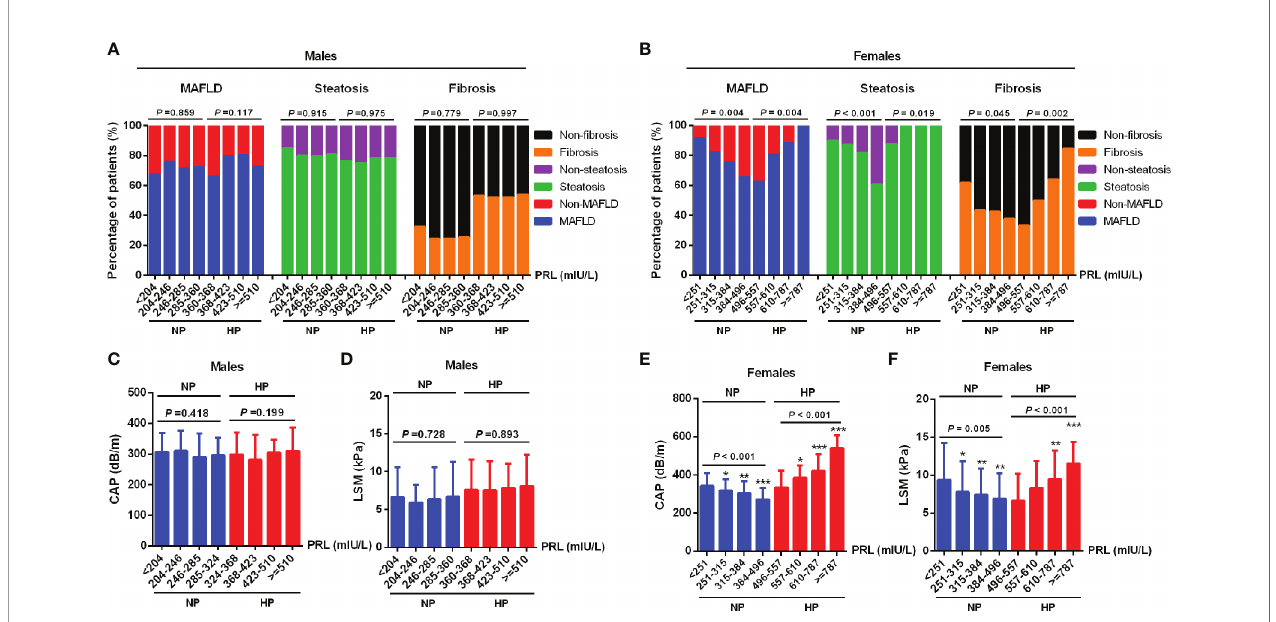
FIGURE 3 | Percentage of MAFLD, liver steatosis, and fi brosis across serum PRL levels in diabetic patients. PRL levels were plotted into four quartiles in both genders. (A) Among males, the percentage of MAFLD, liver steatosis, and fi brosis did not change signi fi cantly across serum PRL quartiles. (B) Among females, there was a signi fi cantly decreasing trend in the percentage of MAFLD, liver steatosis, and fi brosis in the NP group but an increasing trend in the HP group across serum PRL quartiles. (C, D) CAP and LSM values did not change signi fi cantly across serum PRL quartiles among males. (E, F) Among females, CAP and LSM values were signi fi cantly decreased in the NP group but increased in the HP group across serum PRL quartiles. CAP, controlled attenuation parameter; LSM, liver stiffness measurement. P -values <0.05 were accepted as statistically signi fi cant. * P < 0.05, ** P < 0.01, *** P <